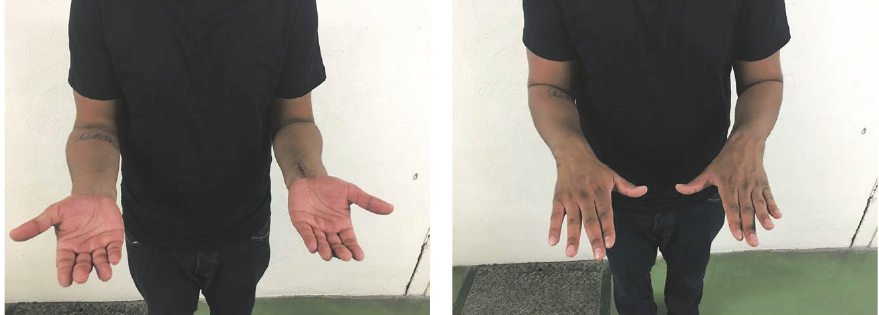
Figure 5: Clinical exam at 6 weeks after surgery showing full symmetrical pronation/supination.